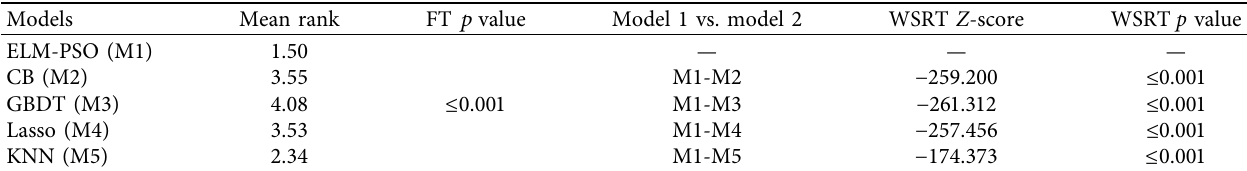
Figure 9: MAE, RMSE, and R -squared values on training and test sets with different data sizes (LASSO1 represents the performance on training set; LASSO2 represents the performance). Table 6: Friedman ranking test and WSRT